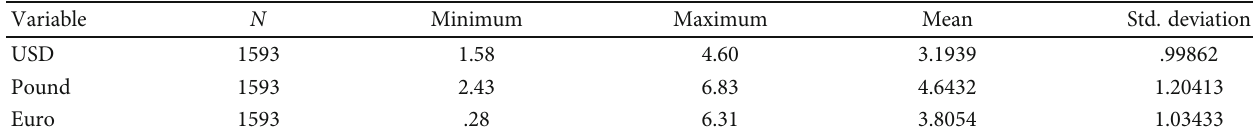
Table 2: Descriptive